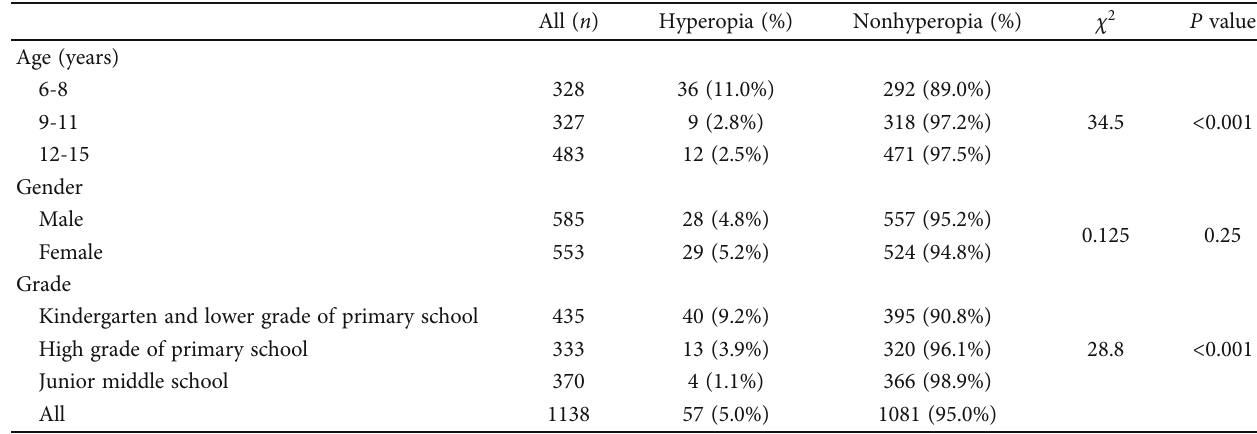
Table 3: Prevalence of hyperopia by age, gender, and grade.